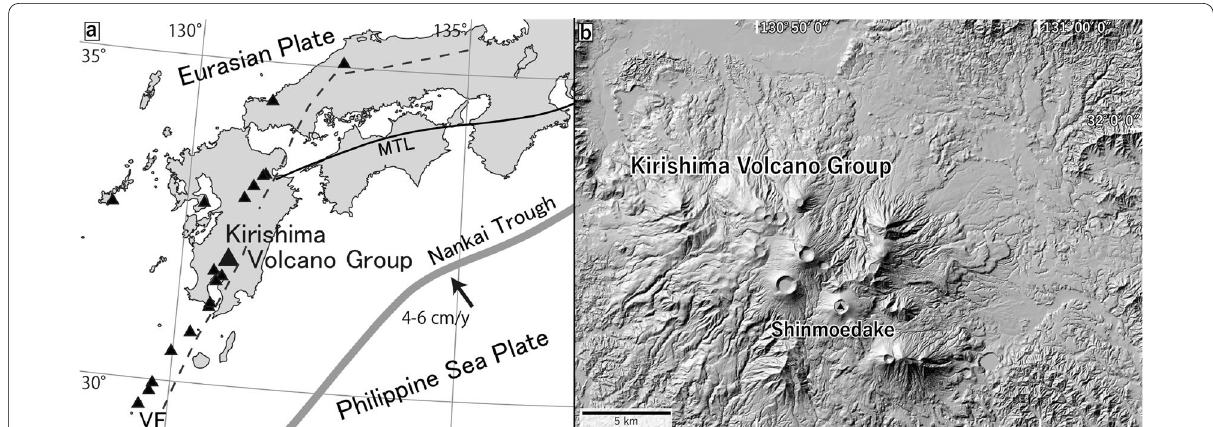
Fig. 1 Location index map of the Kirishima Volcano Group. a Index map of western Japan. VF: volcanic front. MTL: median tectonic line fault zone. b Shading relief map of the Kirishima Volcano Group obtained using the website of the Geospatial Information Authority of